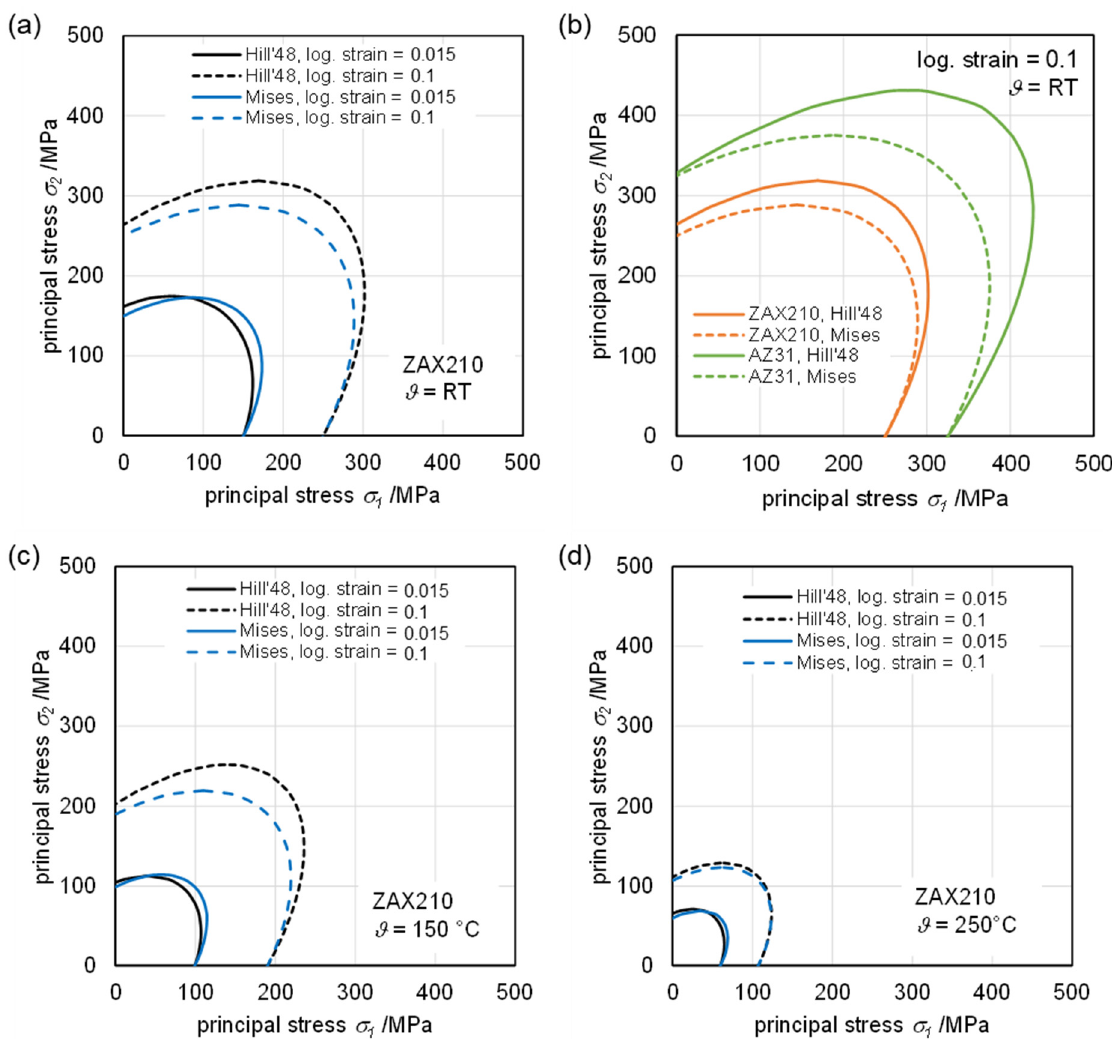
Figure 6. Yield loci of ZAX210 calculated with Hill’48 considering the r -values at different logarithmic strains, partly in comparison with Mises: ( a ) at room temperature, ( b ) at room temperature in comparison with AZ31, ( c ) at 150 °C, ( d ) at 250 °C.